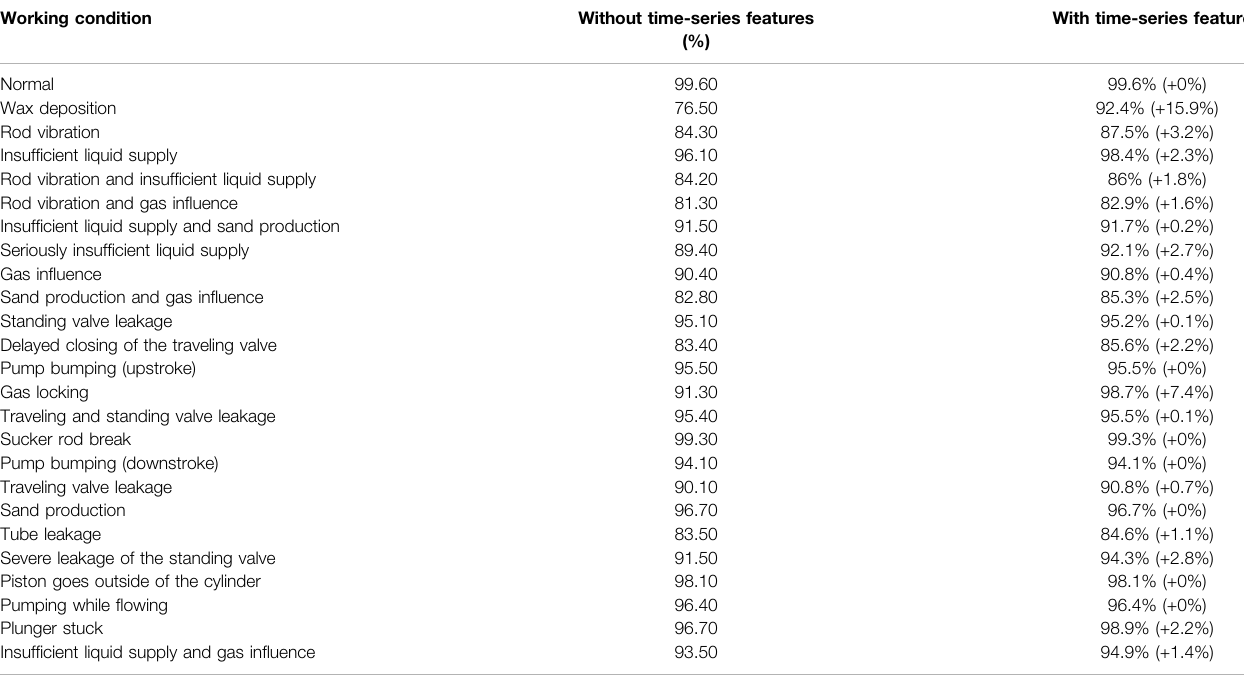
TABLE 8 | Test results of different working conditions.